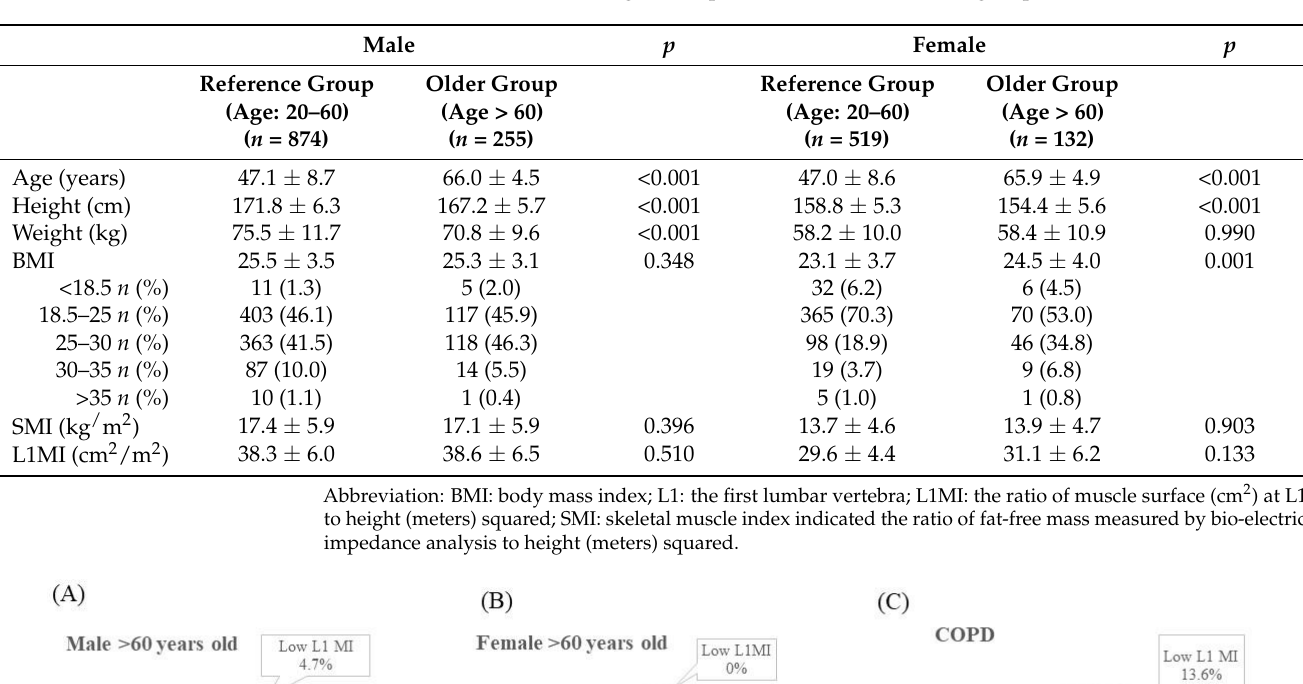
Table 2. The characteristics of gender-specific reference and older groups.